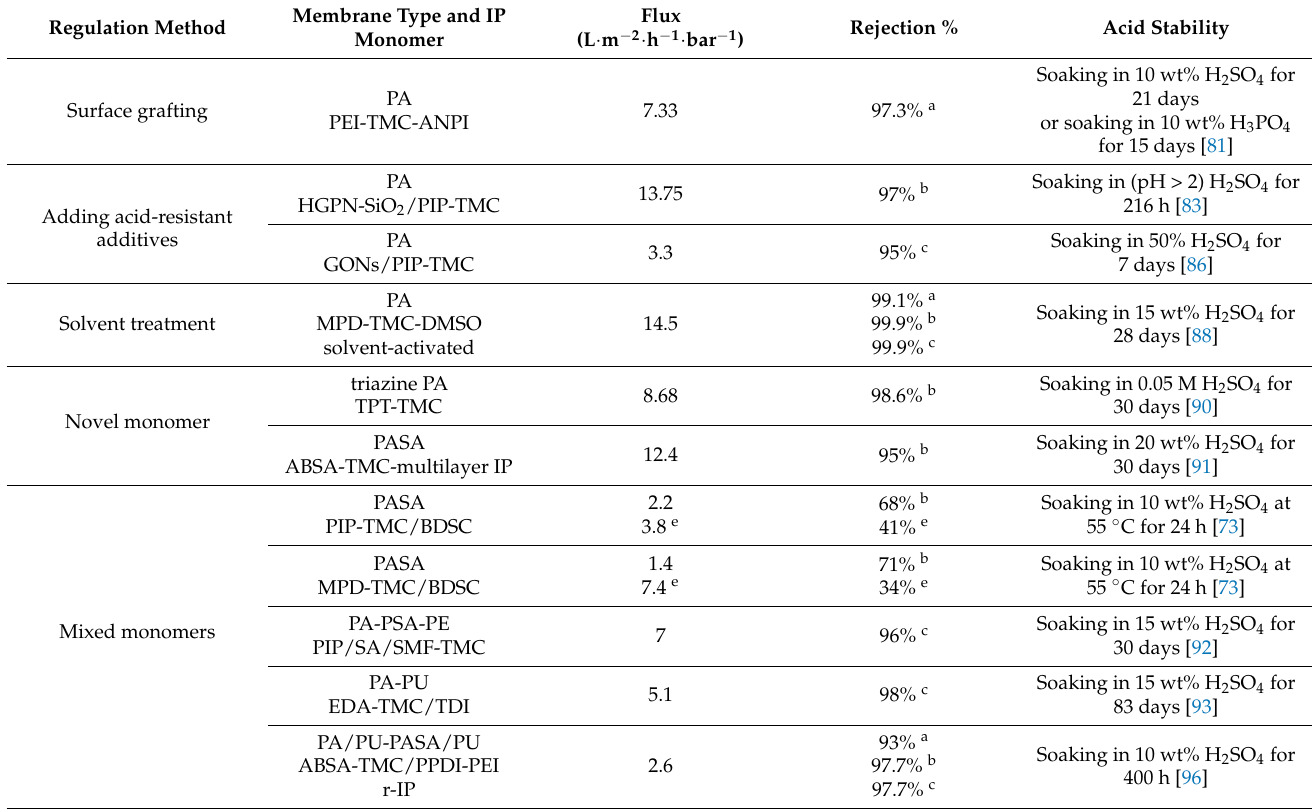
Table 1. Regulation method and acid stability of PA NF